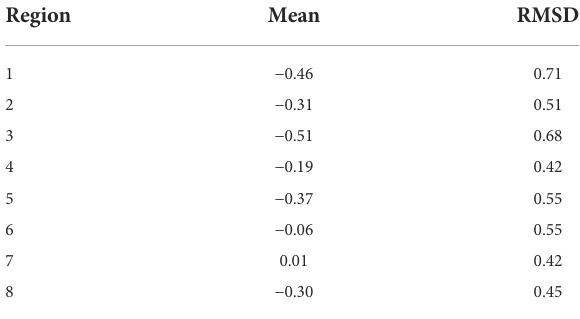
TABLE 1 Bias and RMSD of the SST [ ° C] – (MITO vs. satellite